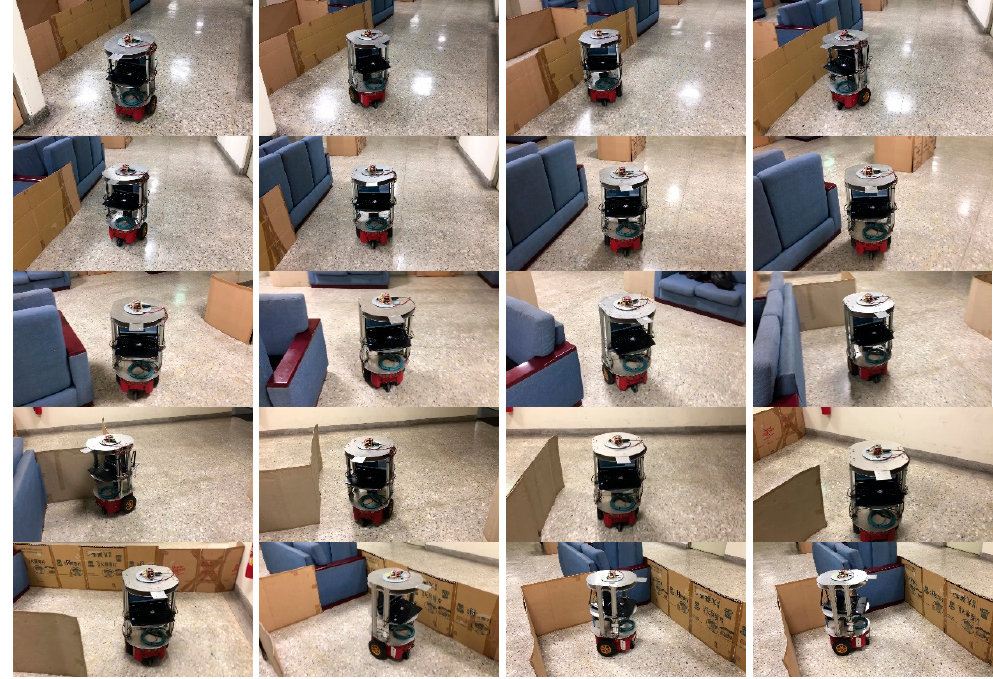
Figure 12. Snapshots of navigating the robot in a real experimental environment (left–right, top–down).